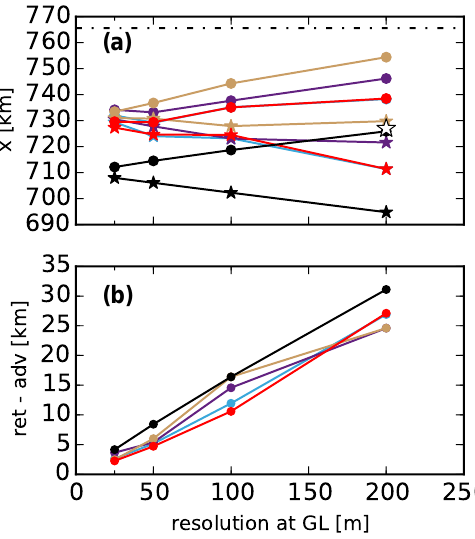
Figure 2. Experiment MISMIP 3a step 3: (a) grounding line po- sitions as a function of resolution in advance (stars) and retreat (dots) for L = 0m and the three GL implementations LG (brown), DI (purple) and FF (blue), L = 60m (red) and L = 500m (black), (b) model accuracy estimated from the difference between the re- treat and advance GL steady positions (same colour legend). In (a) , the large white star corresponds to the published GL position for step 4 of experience 3a in Pattyn et al. (2012) and the dot-dashed line is the Schoof (2007)